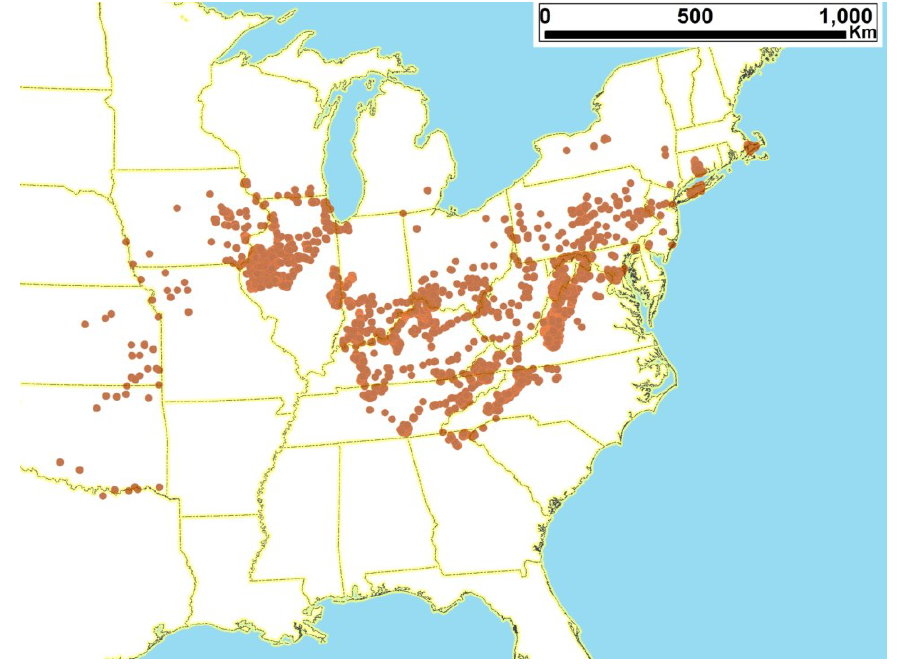
Figure 30. Distribution of the 17-year Magicicada species (brown circles). All species are represented collectively with each location being a single or multiple species. The distribution of individual species follows the patterns outlined in the